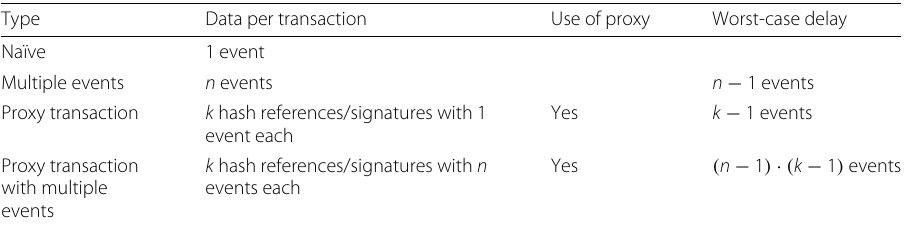
Table 3 Types of scalability in